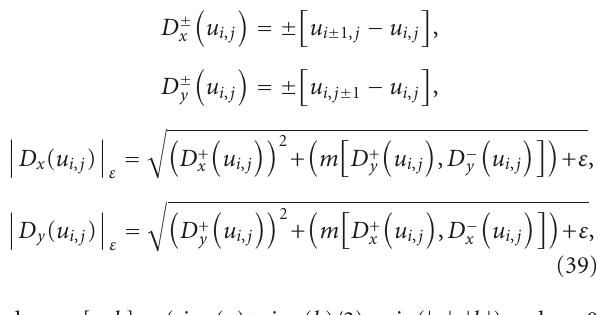
Figure 5: The restored “Toys” images (a) by the curvelet shrinkage method (SNR = 13.33, MSSIM = 0.85); (b) by using the “TV” model (SNR = 14.21, MSSIM = 0.85); (c) by using the “TVGF” model (SNR = 13.28, MSSIM = 0.72); (d) by using our proposed model (SNR = 14.37, MSSIM =